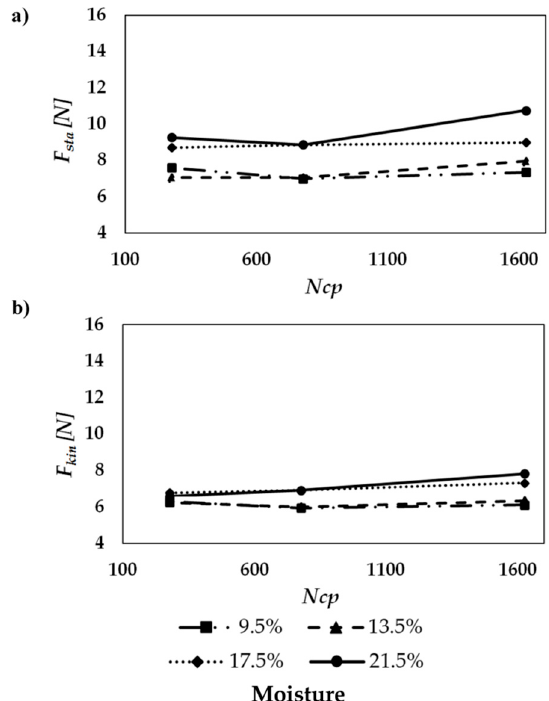
Figure 9. A chart showing the relationship of force of friction to the number of contact points for buckwheat, ( a ) static friction, ( b ) kinetic friction.